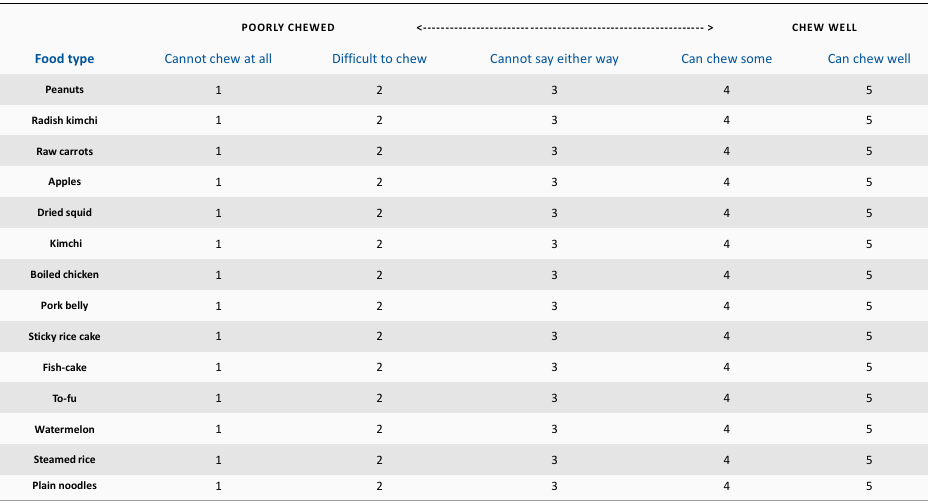
Figure 1. FIA questionnaire on 14 food items.